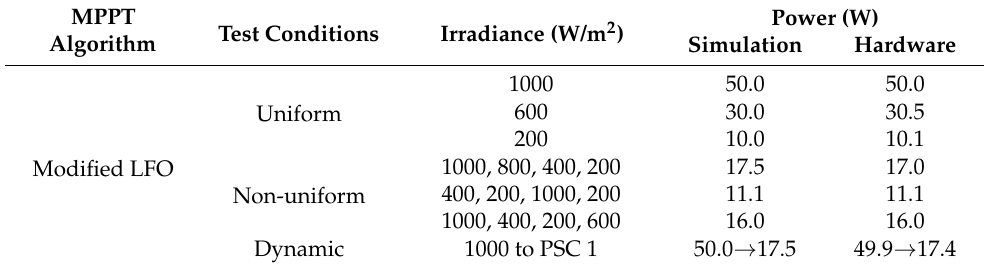
Table 6. Comparison between P&O, PSO, and the proposed algorithm.